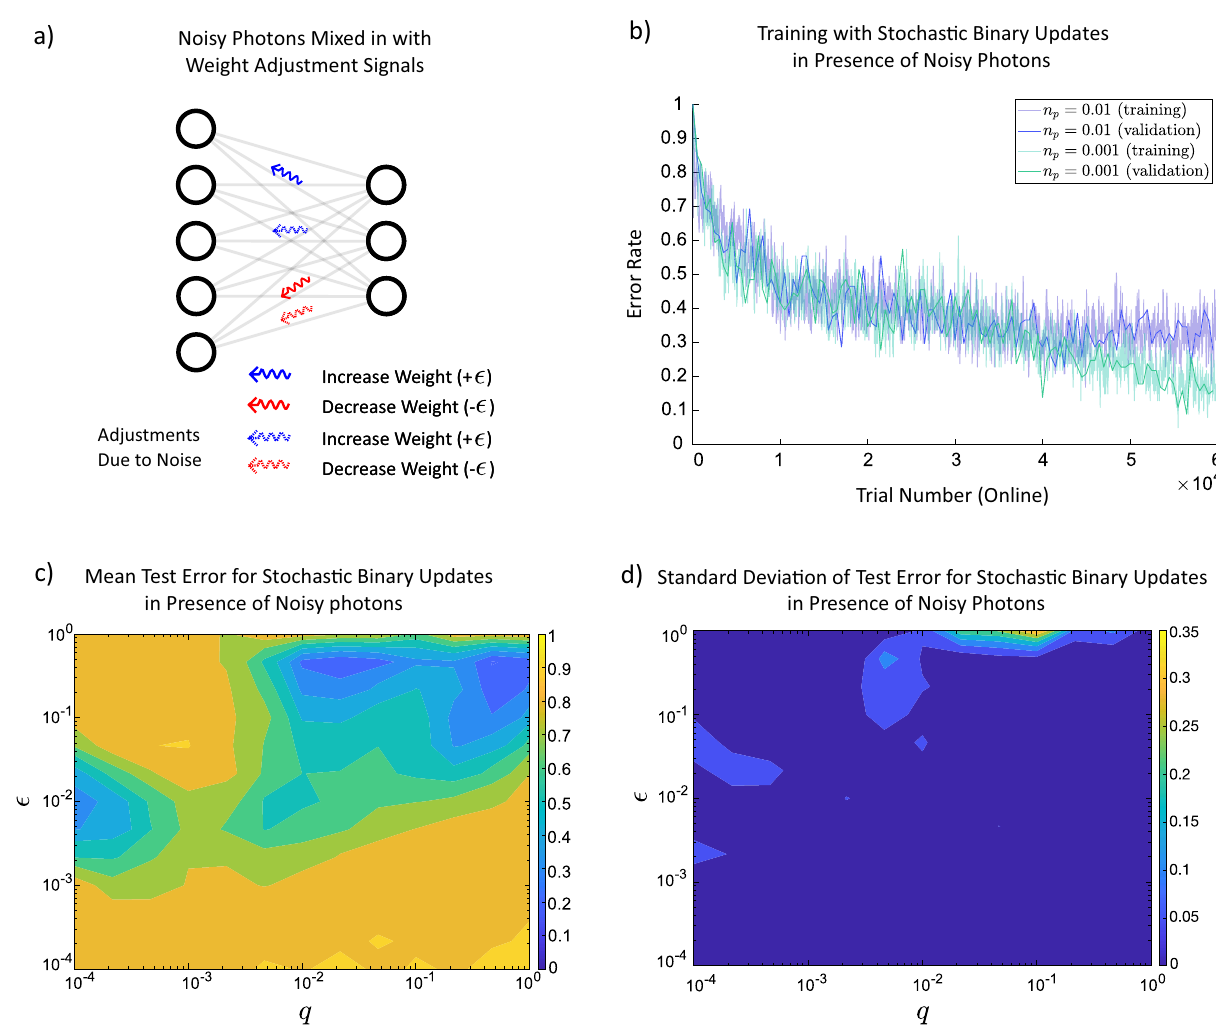
Figure 4. Training of a 3-layered artificial neural network by the noisy stochastic photonic updates with binary signal limit. ( a ) After evaluation of the network, binary photonic signals are transmitted back to update weights, however, in the presence of uncorrelated noisy photons. ( b ) Here, the deterministic photon emission rate, q = 0.1 , and the learning rate, ǫ = 0.1 , are given for a network with 500 units in the hidden layer. The error rate depends on the noisy photon rate, n p which defines the probability of emitting noisy photon update. ( c ) The average error rate after 10 trials has increased due to the noise in the system. Here, n p = 0.01 . There are still areas in the graph where learning is happening. This figure is generated after training 10 different networks for each mesh point and taking the average on the test error. ( d ) The standard deviation of the test error after running 10 different